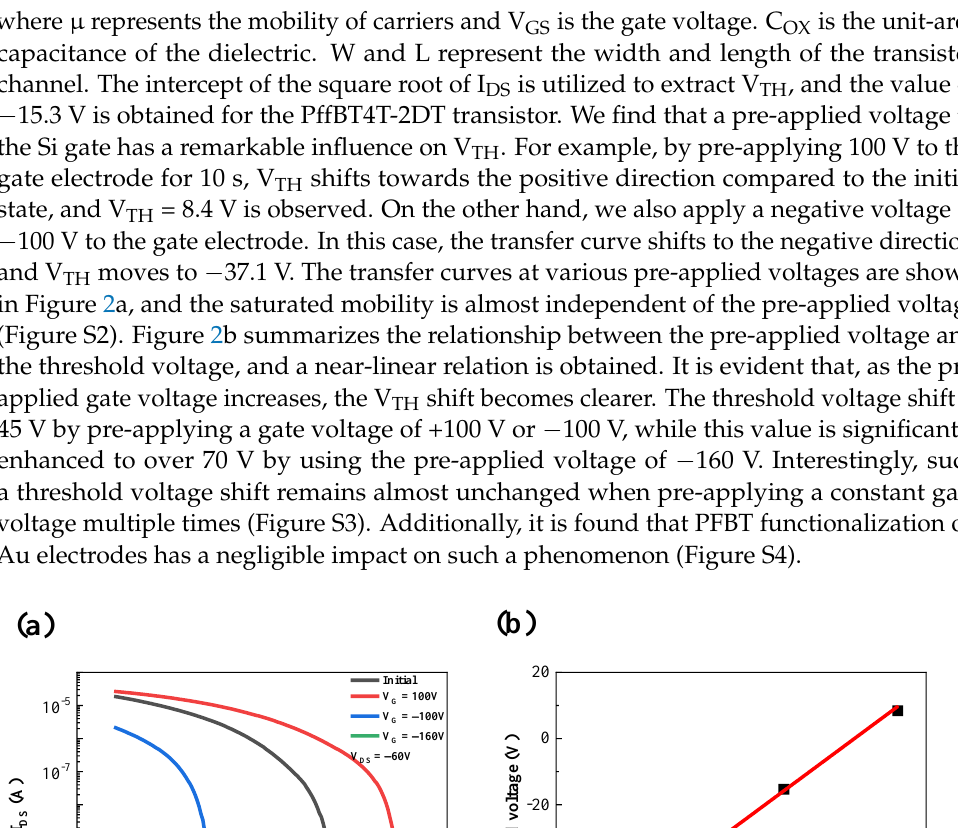
Figure 1. Chemical structures of PFBT (top) and PffBT4T-2DT (bottom) and schematic structure of the fabricated OFET.